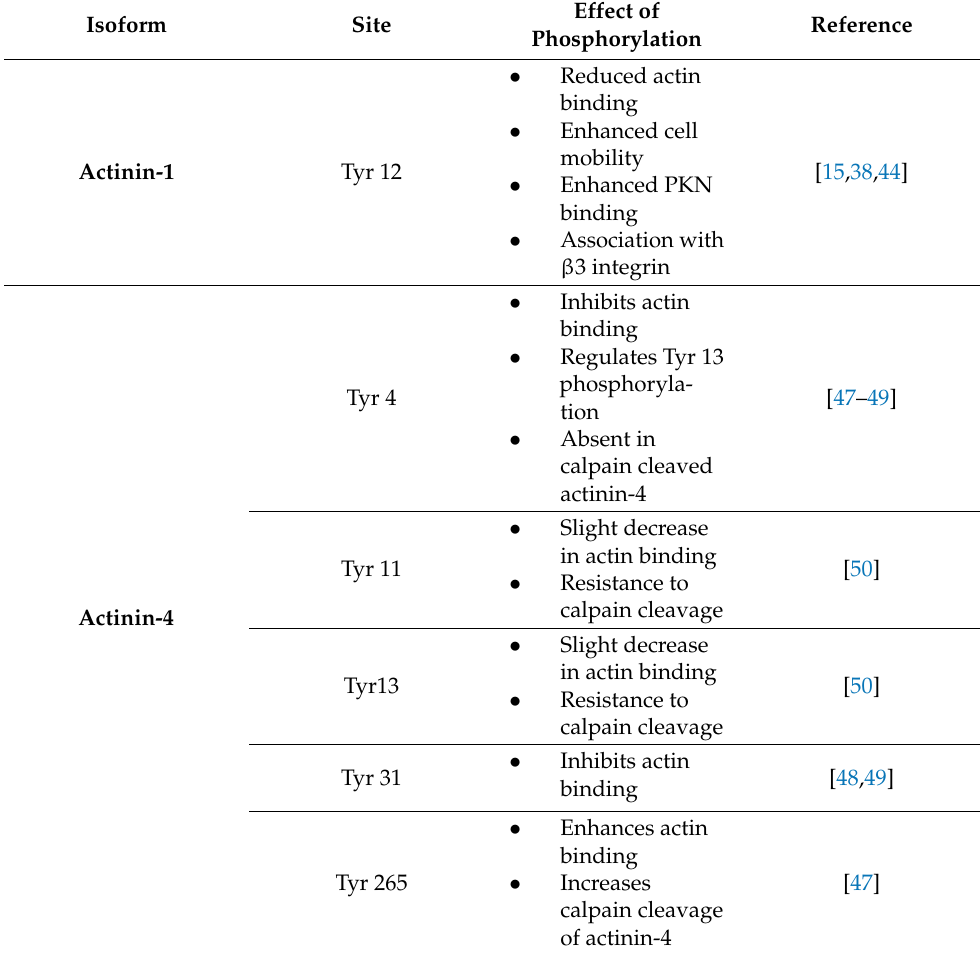
Table 1. Regulation of non-muscle actinins by tyrosine